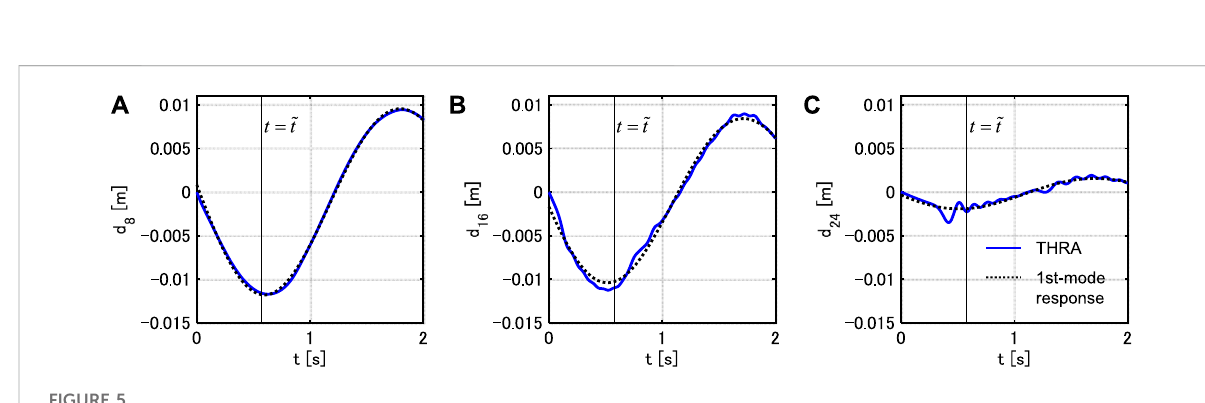
FIGURE 5 Interstory drift response time-history under PSI (Model 2), (A) 8-th story, (B) 16-th story, (C) 24-th